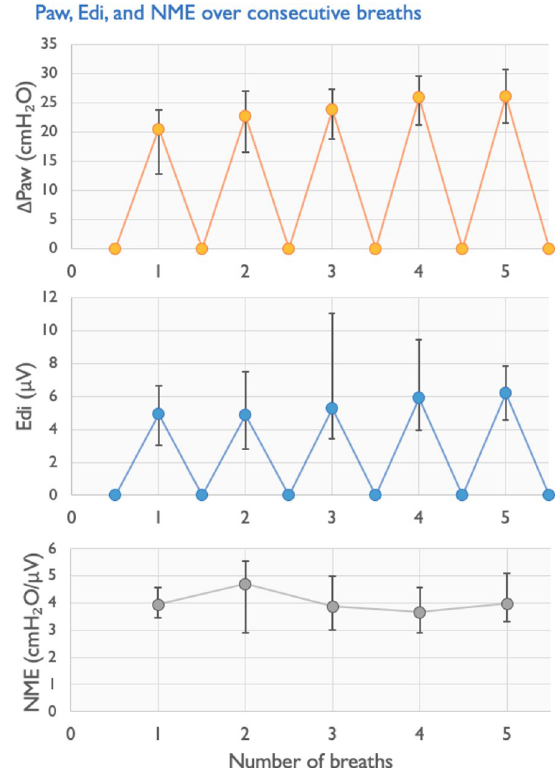
Fig. 1 Median (interquartile) evolution of Paw, eadi, and NME ratio over the 5 breaths of occlusion